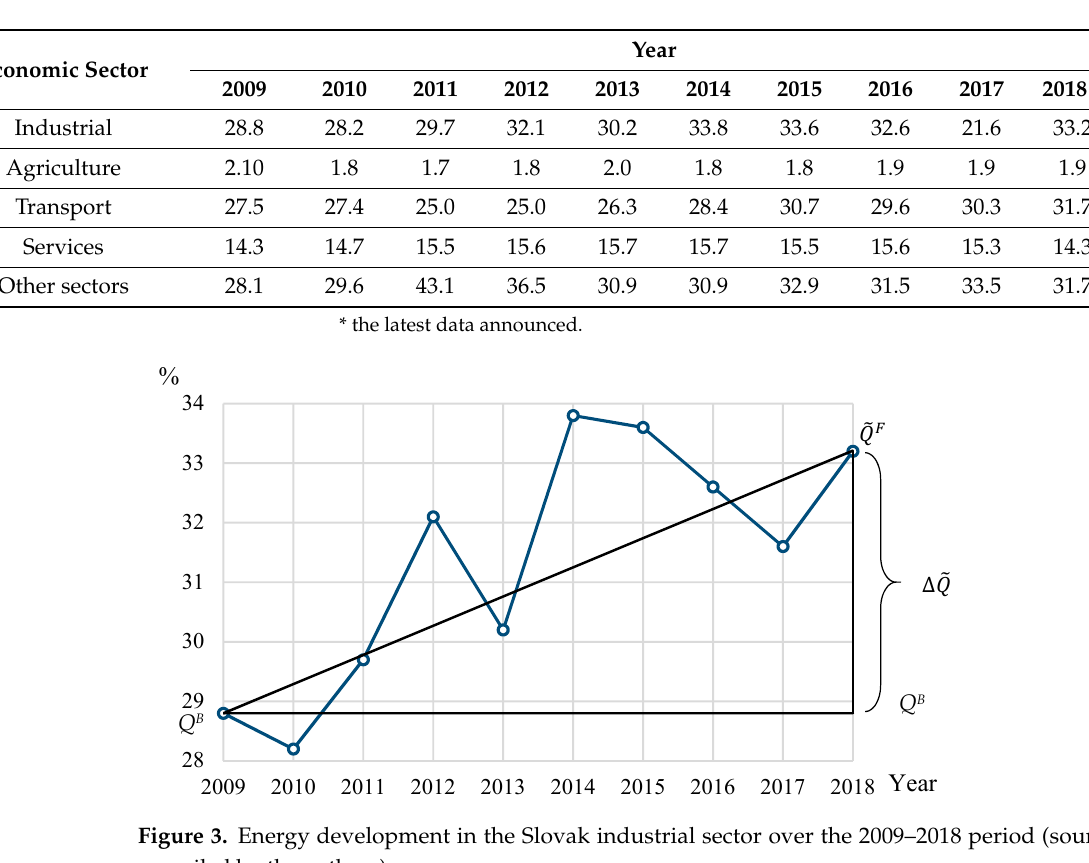
Table 1. Typical cases of fluctuations in sectoral energy development in target countries over the 2009–2018 period, percentage of total electric energy consumption (source: compiled by the authors with reference to Indicator for Sustainable..., 2002 [15]).